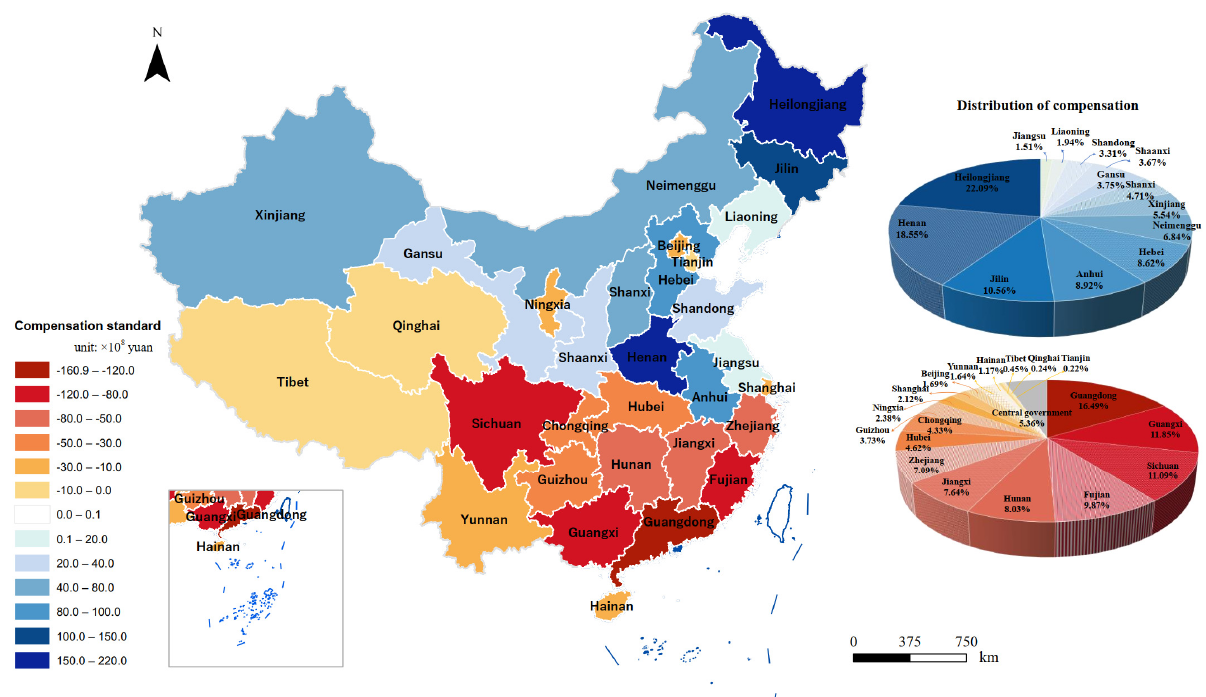
Figure 3. Provincial ecocompensation standard for cultivated land of China in 2018.